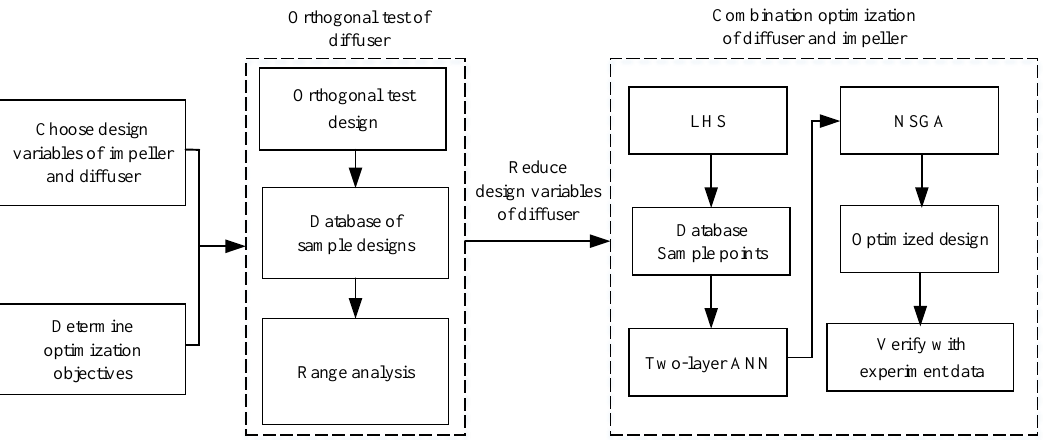
Figure 4. The optimization procedure of the reversible axial-flow pump.